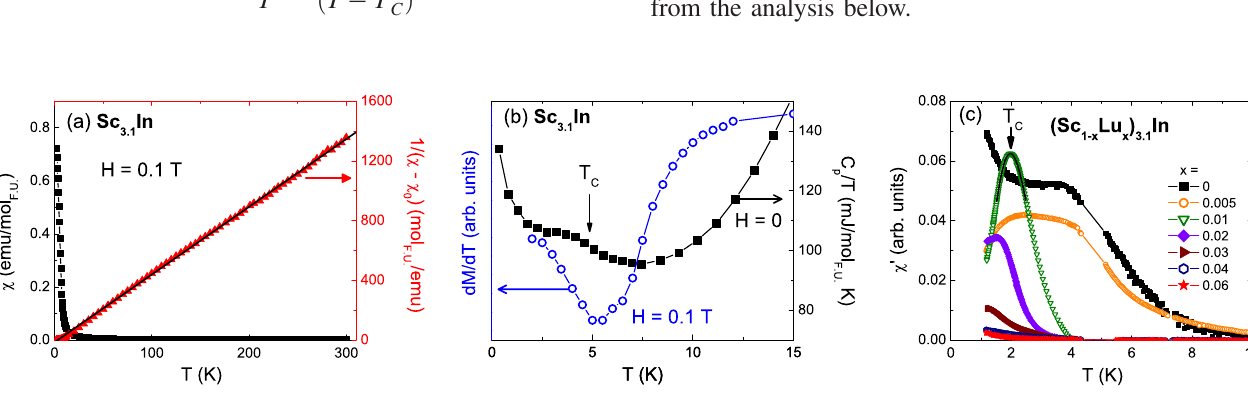
FIG. 2. (a) Sc 3 In susceptibility (left) and inverse susceptibility 1 = ð χ − χ 0 Þ (right) for H ¼ 0 . 1 T, where χ 0 ¼ C=T (cid:4) (see text). . 1 (b) The magnetization derivative dM=dT (left) and specific heat C Þ temperature T . (c) ð Sc 1 − Lu 3 . 1 In ac susceptibility C x x indicated by the vertical